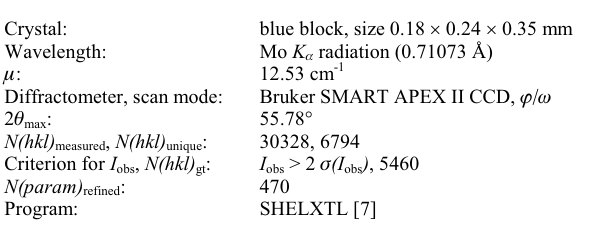
Table 1. Data collection and handling.